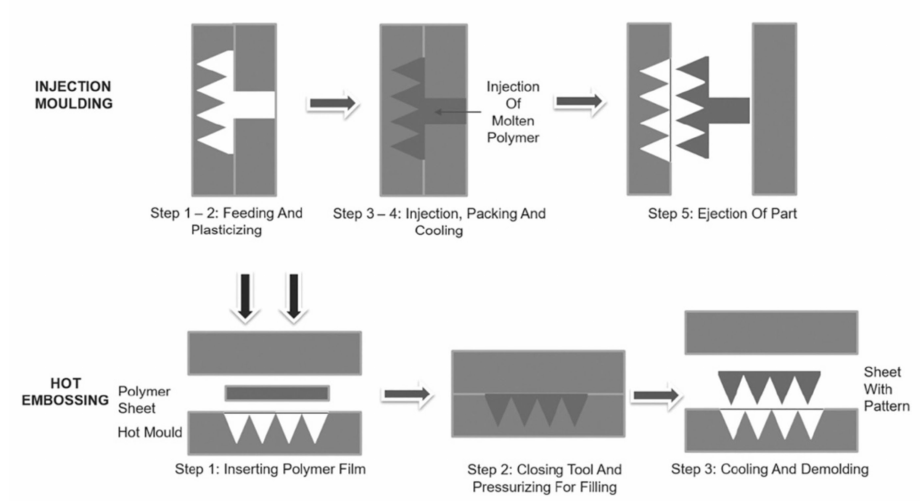
Figure 14. Process steps of standard injection molding and step-and-repeat hot embossing [152]. Reproduced with permission from Herwig Juster et al., A review on microfabrication of thermoplastic polymer-based MN arrays; published by John Wiley and Sons, 2019. copyright © 2021 Society of Plastics